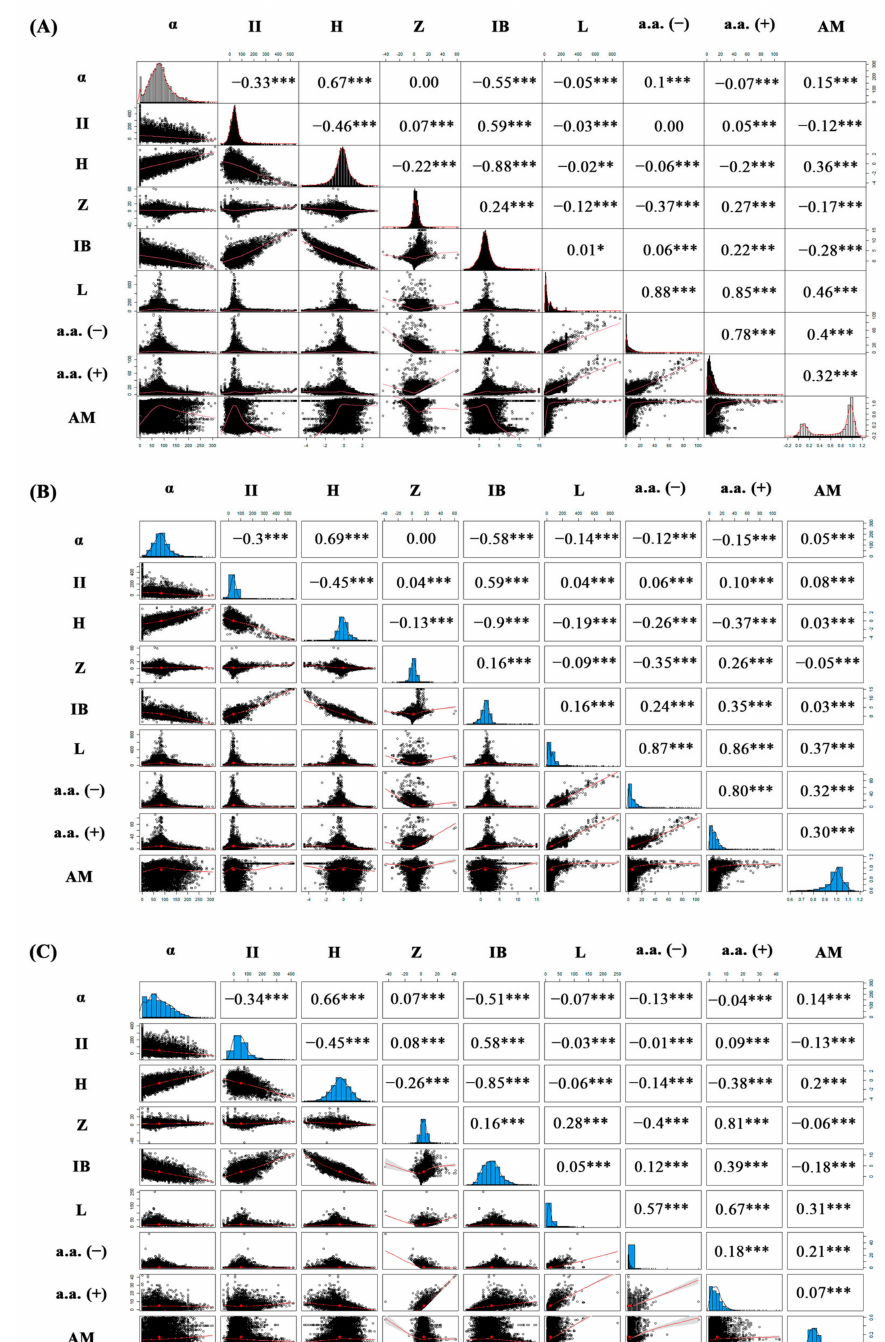
Figure 6. Correlations between physicochemical properties of AMPs and AMPs prone to amyloido- genicity (AM) ( A ). α is aliphatic index, II is instability index, H is hydrophobicity, Z is charge, IB is Boman index, L is antimicrobial peptide length, a.a. (+) is positively charged a.a., a.a. ( − ) is negatively charged a.a., AM is amyloidogenicity. The result of a stochastic cluster analysis of AMPs prone to amyloidogenicity (AM). The correlation matrices of the distribution between the physico- chemical properties of AMPs and AMPs, both prone and not prone to amyloidogenicity, respectively, ( B ) and ( C ). The calculations were performed in the R package. Symbol “*” means the most significant correlations between properties. The greater the number of “*”, the more significant the correlation between the physicochemical properties of AMPs and amyloidogenicity